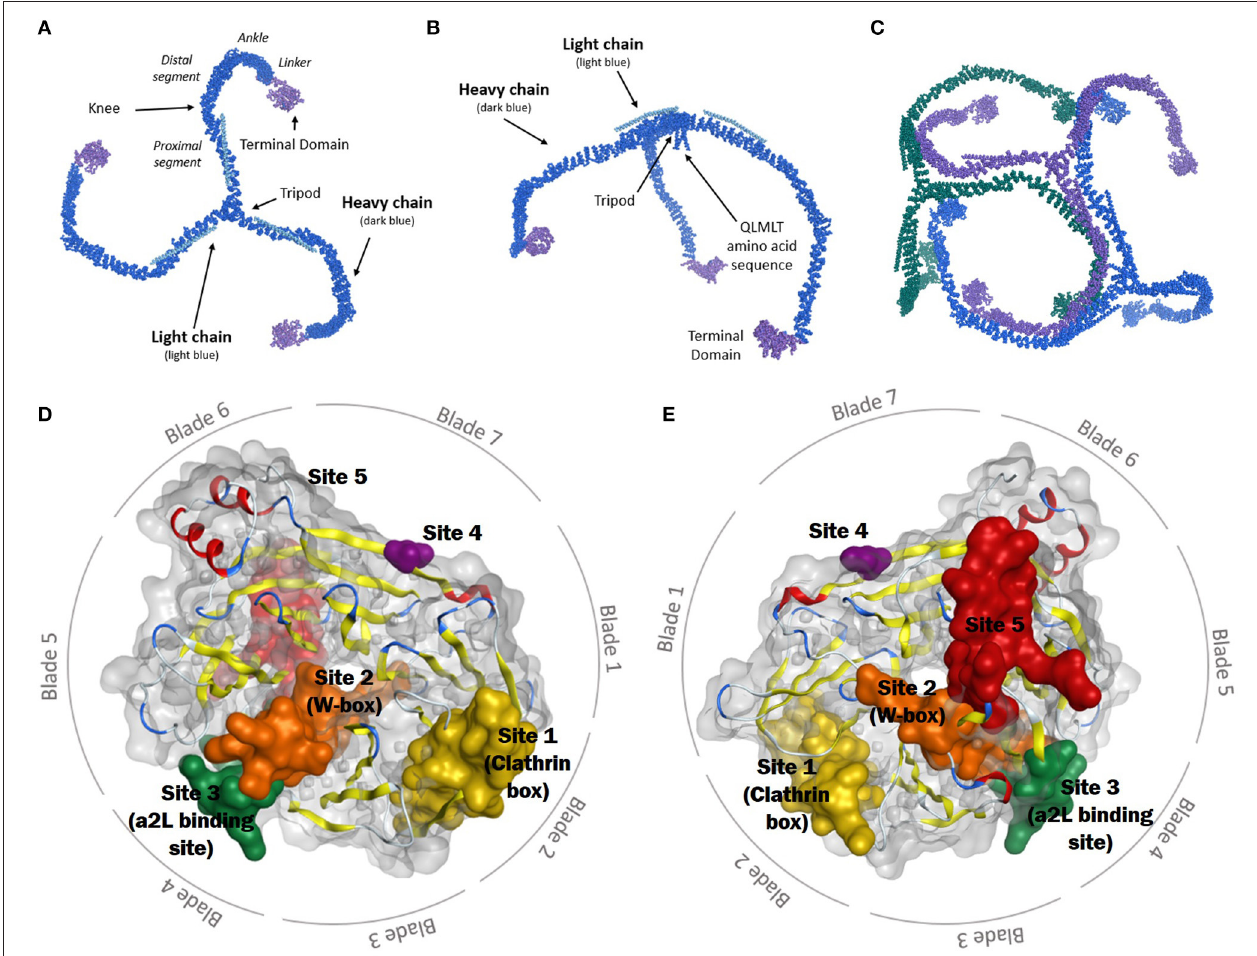
FIGURE 1 | (A) Schematic representation of the clathrin triskelion (top view). The heavy chain is displayed in dark blue, the light chain in light blue, and the terminal domain in purple. (B) Side view of clathrin triskelion showing the location of the tripod and QLMLT amino acid sequence at the central vertex. (C) Schematic representation of three clathrin triskelions bound in lattice formation. Each singular triskelion represented in a different colour (blue, green, and purple) ( Fotin et al., 2004a ). (D) Top view of the CTD, consisting of seven blades. The binding sites are shown: Yellow: Site 1 (clathrin box), orange: Site 2 (W-box), green: Site 3 (aL2 binding site), purple: Site 4, red: Site 5. (E) Bottom view of the CTD, showing the seven blades and five binding sites (Alsaqati et al., 2018).